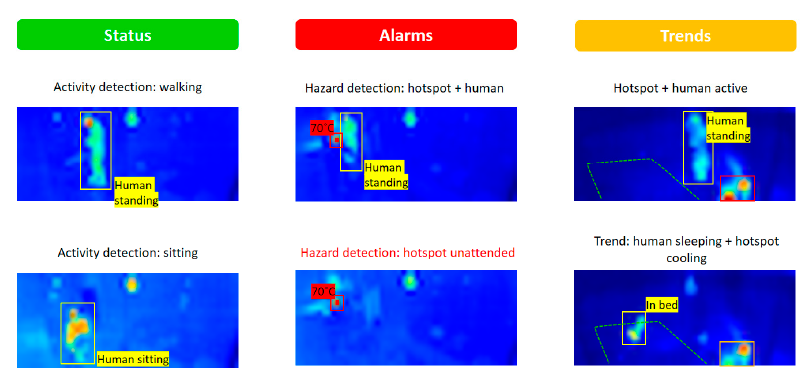
Figure 11. Sample of activity and hazard